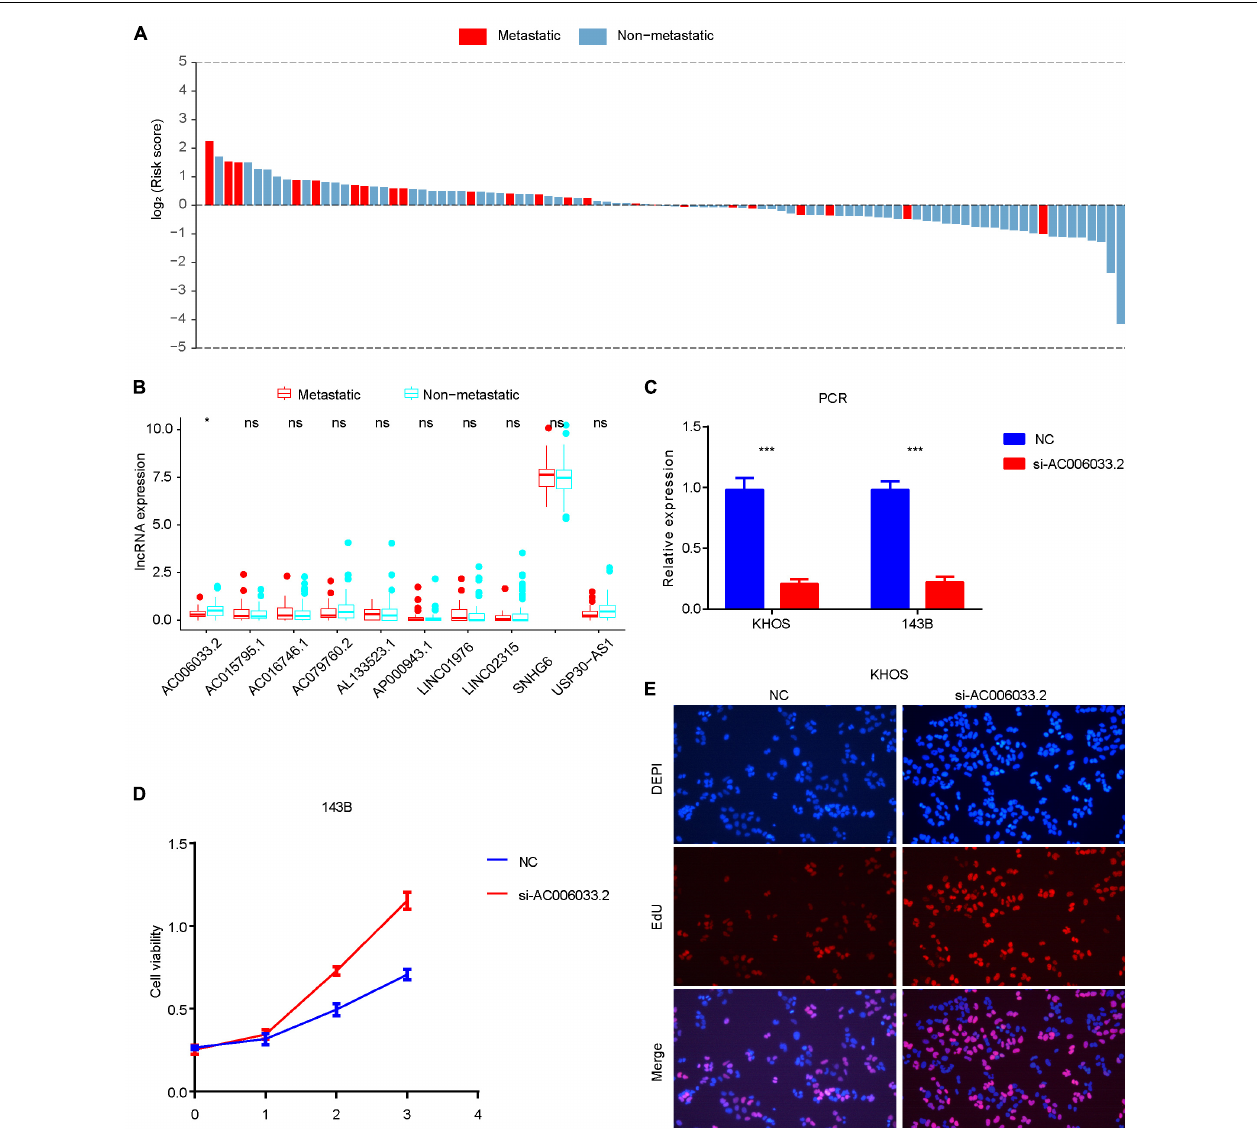
FIGURE 5 | Role of IRLs signature in metastasis and proliferation of osteosarcoma. (A) The probability of metastasis of osteosarcoma gradually decreases with the decrease of risk score. (B) Differential expression of 10 IRLs in metastatic and non-metastatic osteosarcomas. Only the expression level of AC006033.2 was different. (C) Knockdown results of AC006033.2 in osteosarcoma cell lines. (D,E) Effects of AC006033.2 knockdown on proliferation of osteosarcoma cells. * P < 0.05 and *** P < 0.001. EdU, 5-ethynyl-2 (cid:48)